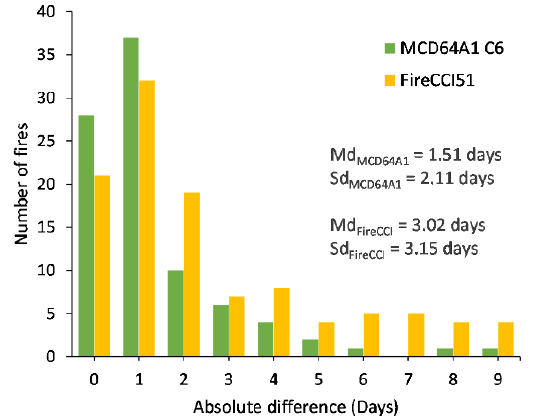
Figure 5. Histogram of absolute temporal difference (in days) between MODIS and Sentinel-2 reference fires for all years. The difference is calculated between the minimum DOY of each MODIS fire and the start date of the corresponding reference fire. The mean (Md) and standard deviation (Sd) of the absolute differences in days are also